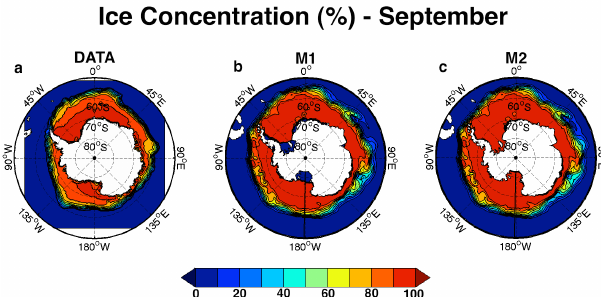
Fig. 10. Sea ice concentration in percentages for September (month of maximum sea ice coverage observed in the Southern Hemi- Fig. 10. Sea–ice concentration in percentages for September (month of maximum observed Southern Hemi- sphere) obtained from the (a) Nimbus-7 SMMR and DMSP SSM/I sphere sea–ice coverage) obtained from the (a) Nimbus–7 SMMR and DMSP SSM/I Passive Microwave Data passive microwave data, (b) M1, and (c) M2 experiments. and (b) M1, (c) M2 experiments.